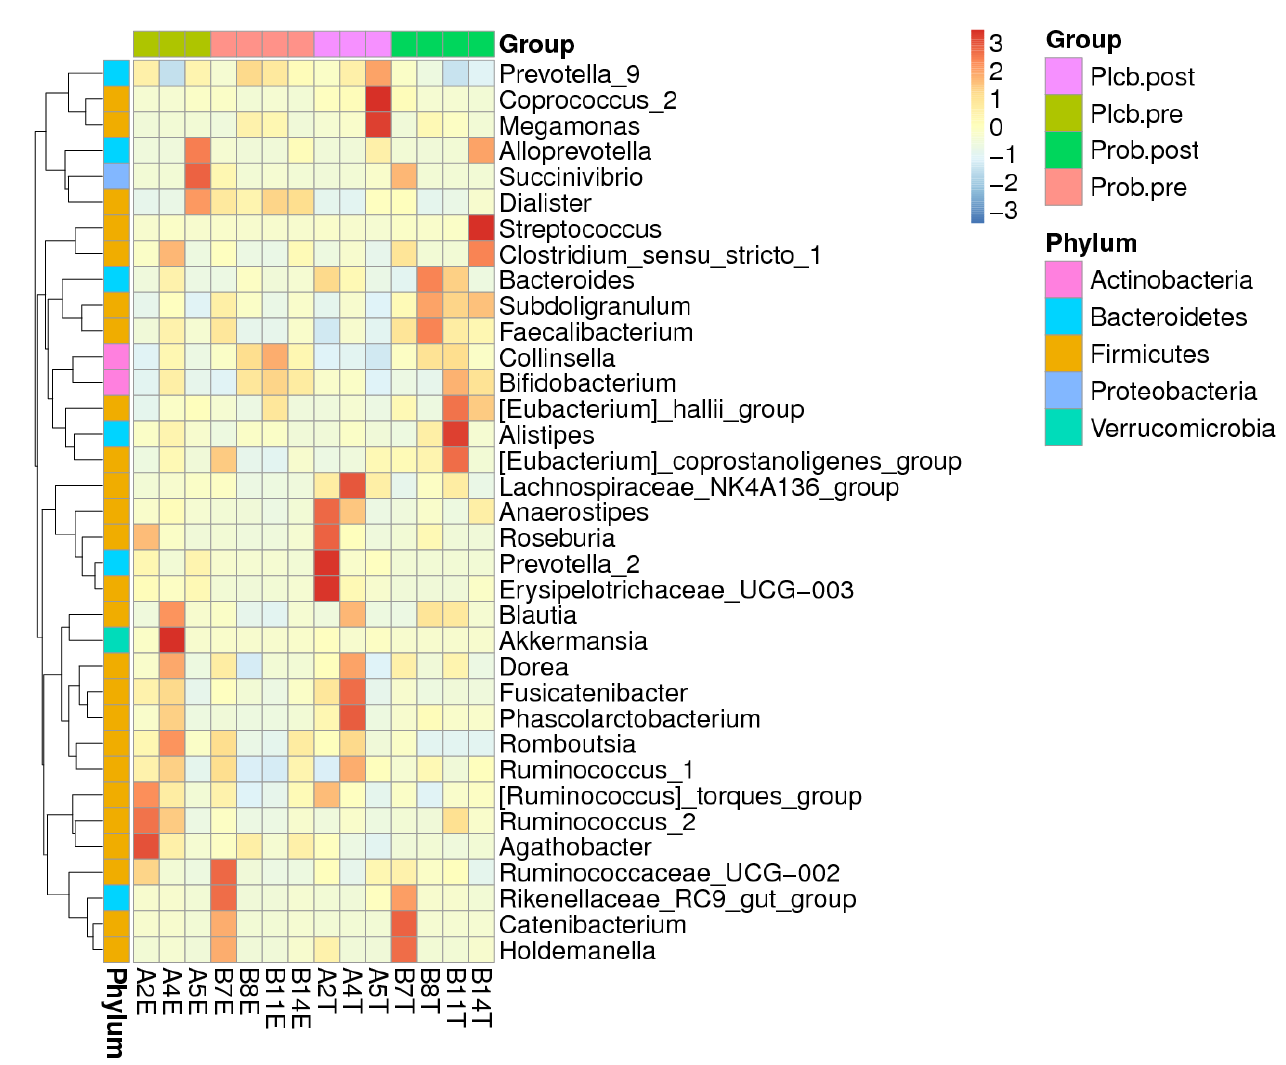
Figure 4. Heatmap of the top 35 relative abundance at the genus level of each subject.